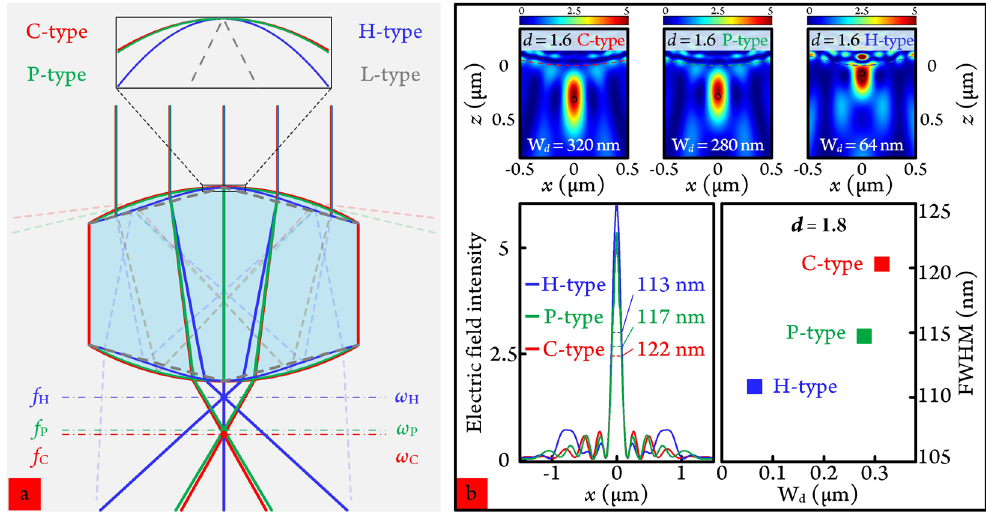
Figure 4. ( a ) Four boundary profiles for narrowing the transverse beam widths of the PNJs. C-type: circular type, P-type: parabolic type, H-type: harmonic-oscillating type, L-type: linear type. ( b ) FWHM beam widths for C-, P- and H-type R-MPCMs with (left panel) d = 1.6 μ m and (Right panel) d = 1.8 μ m. Insets at the top: the electric field distributions of C-, P- and H-type R-MPCMs for d = 1.6 μ m.